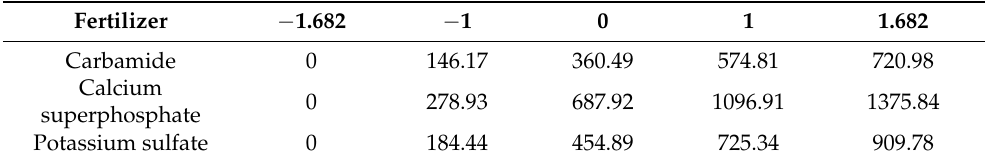
Table 2. Fertilizer application rate and linear coding